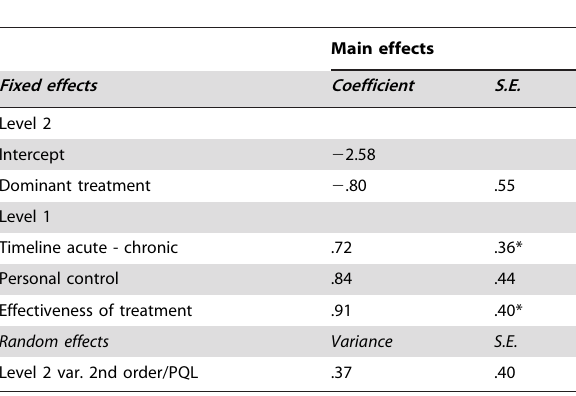
Table 4. Multilevel model with level 1 and level 2